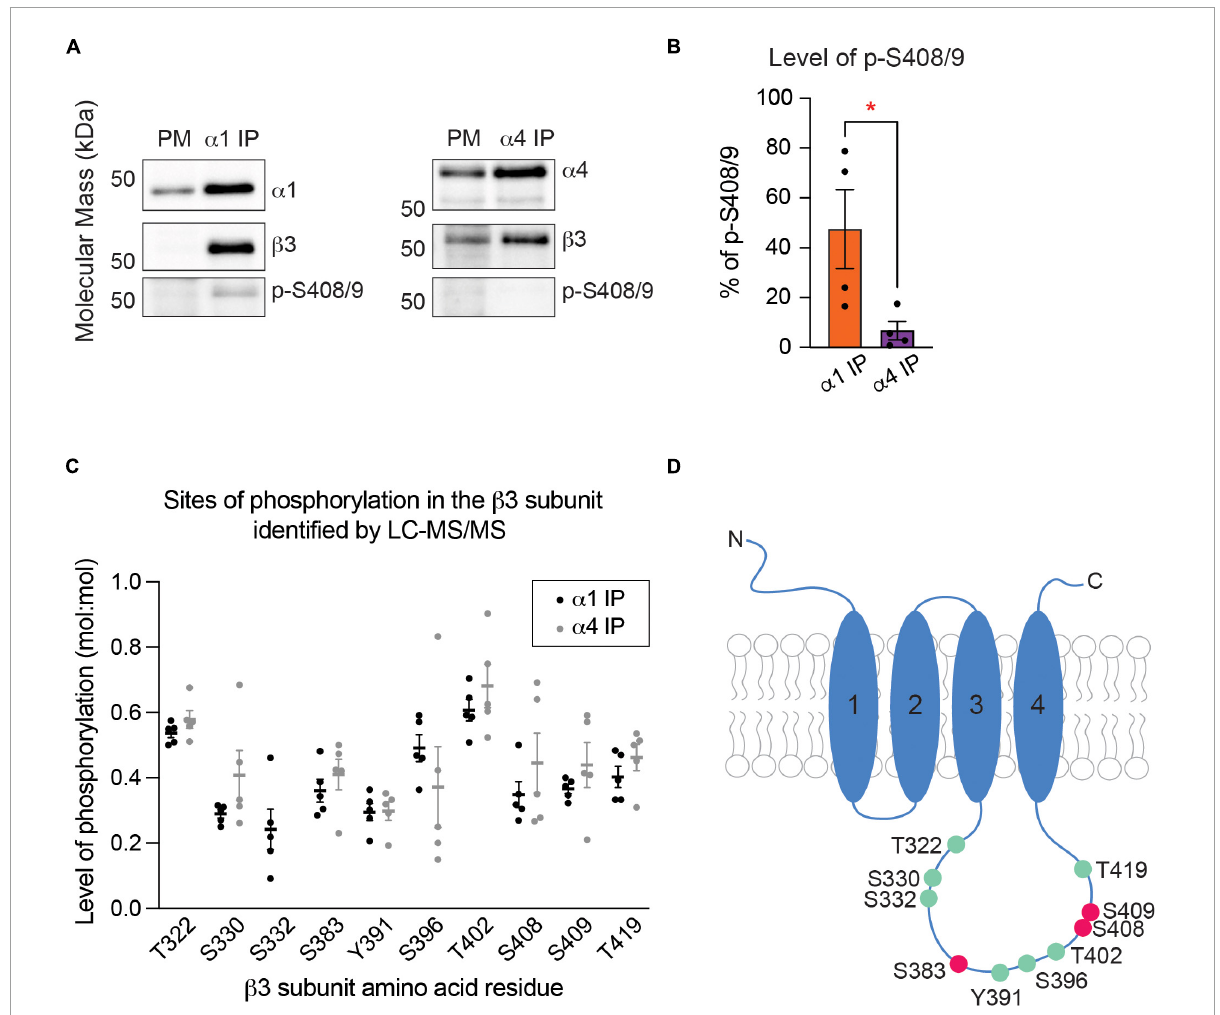
FIGURE4 The β 3 subunit is more highly phosphorylated at S408 and S409 in α 1-containing GABA A Rs than in the α 4 subtype. (A) Immunoblots of purified α 1- and α 4-containing GABA α 1 or α 4 subunit), β 3 subunit, and A Rs were resolved on SDS-PAGE and probed for the target subunit ( phosphorylated S408/9 (p-S408/9). (B) The percentage of p-S408/9 in respect to total β 3 subunit is significantly higher in the α 1 subtype than in the α 4 subtype (* p < 0.05, n = 4 replicates). (C) Spectra searches were performed on LC-MS/MS data obtained from purified α 1- and α 4-containing GABA β 3 subunit. Three known (S383, A Rs to identify phosphorylated serine (S), threonine (T), or tyrosine (Y) residues within the S408, and S409) and seven novel (T322, S330, S332, Y391, S396, T402, and T419) phosphorylation sites were detected. S332 was detected